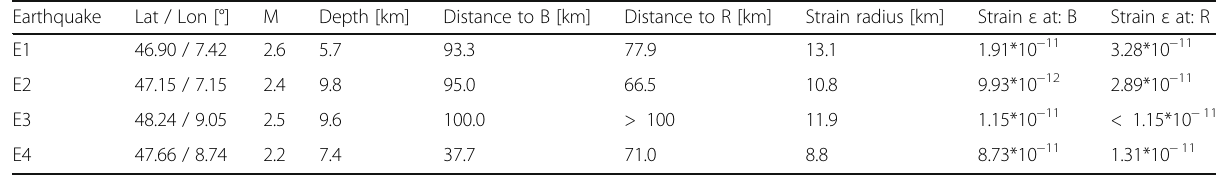
Table 1 The registered earthquakes during the measuring period with a magnitude higher than 2.0 are listed below with the corresponding geographical coordinates (Lat / Long), magnitude (M) and depth of the earthquakes. E1, E2, E3, E4 are identification numbers for the earthquakes which are mapped in Figs. 4, 5 and 6. The distances between the epicentres and the measurement locations Baden (B) and Rheinfelden (R) were calculated. The strain radius was calculated by means of Eq. 1. Strains at the monitoring site R and B are calculated by Eq. 2